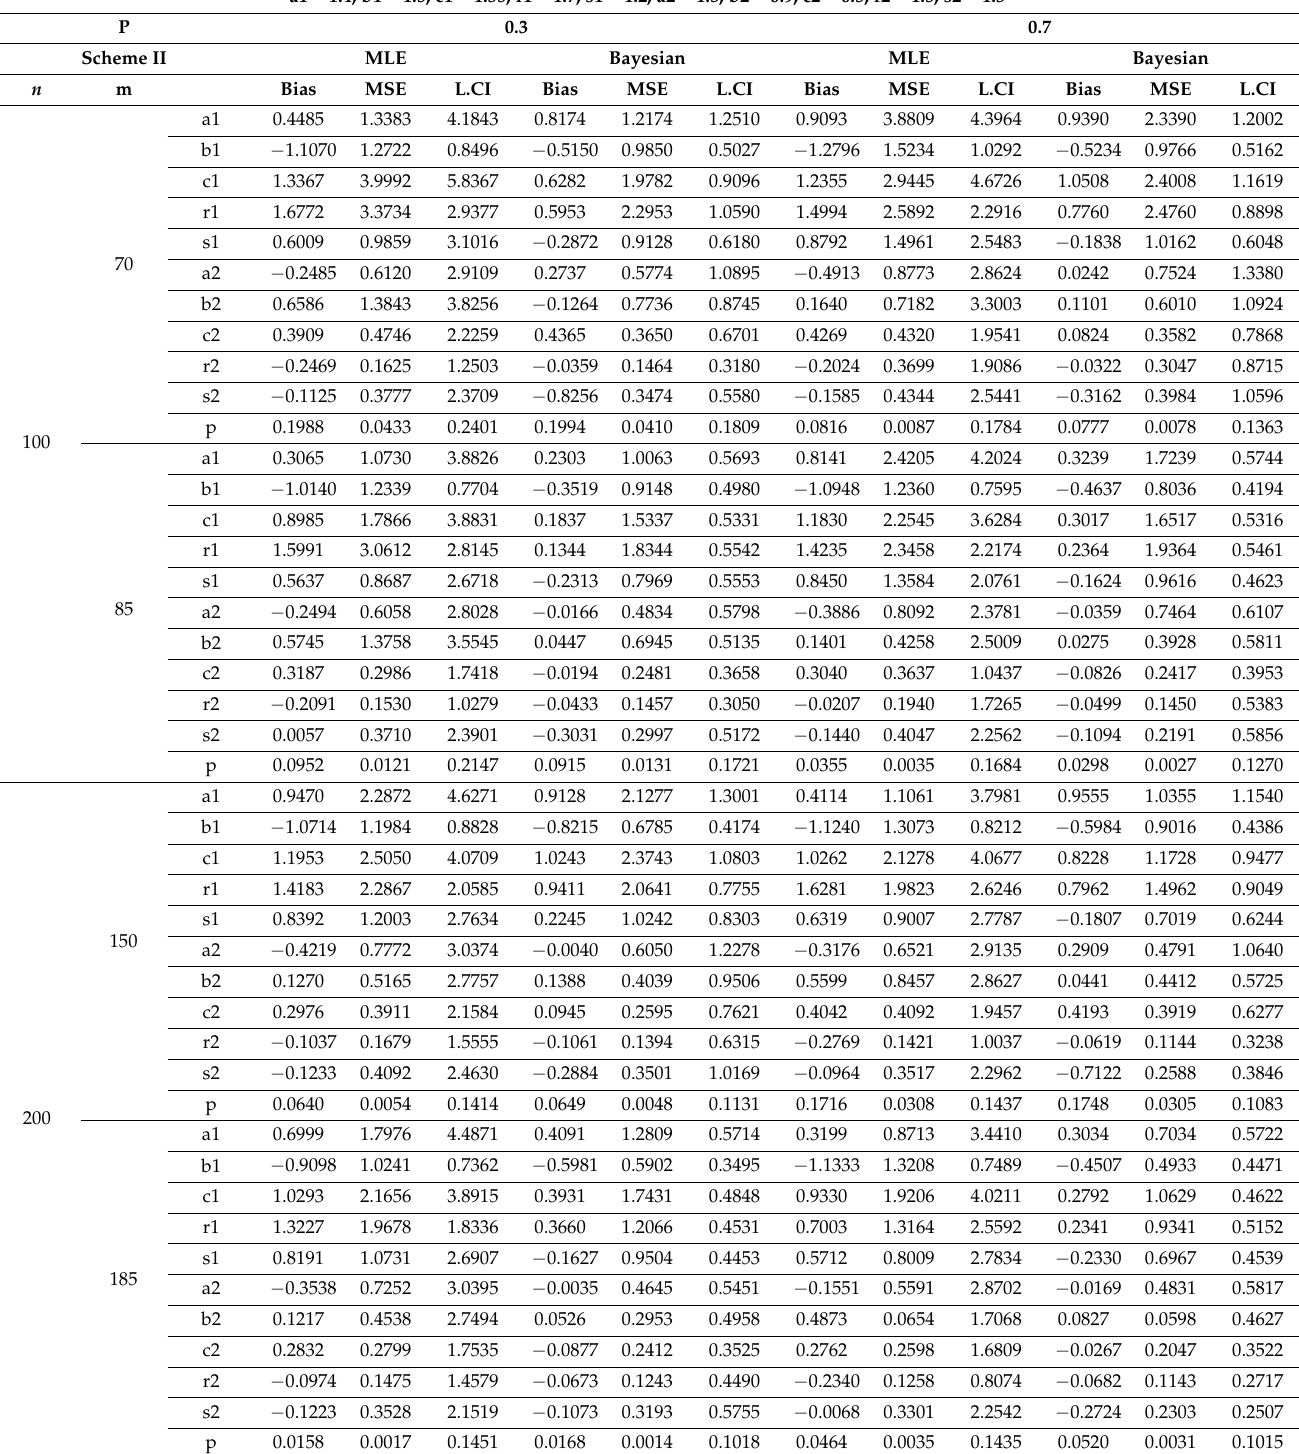
Table 3. MLE and the Bayesian estimates for 11 parameters of MEKGEKF model based on a progres- sively type II censoring scheme: scheme